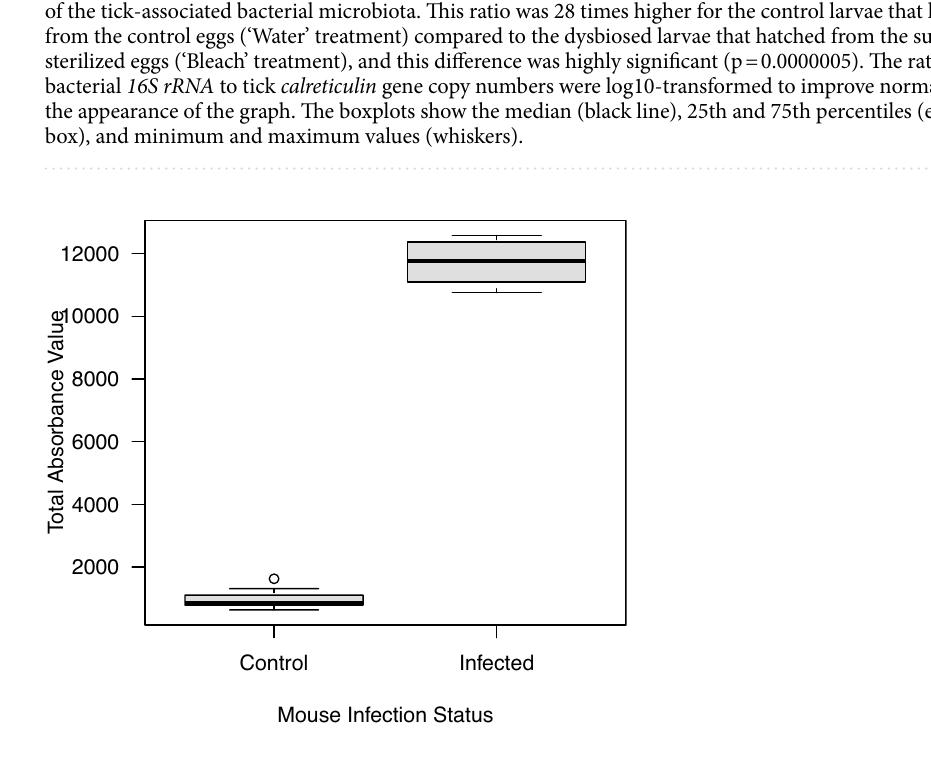
Relationship between engorged larval weight and unfed nymphal weight. The engorged lar- val weights and unfed nymphal weights were both measured for a sample of 653 I. ricinus ticks. The log10- transformed engorged larval weight was a highly significant predictor of the log10-transformed unfed nymphal weight, and the former explained 72.7% of the variation in the latter (Fig. 4; regression: F 1, 651 = 1738, p < 0.000001; correlation: r = 0.854, t = 41.859, df = 652, p < 0.000001). Given that the engorged larvae and unfed nymphs were weighed independently and more than 10 weeks apart, the strong relationship between these two variables indi-